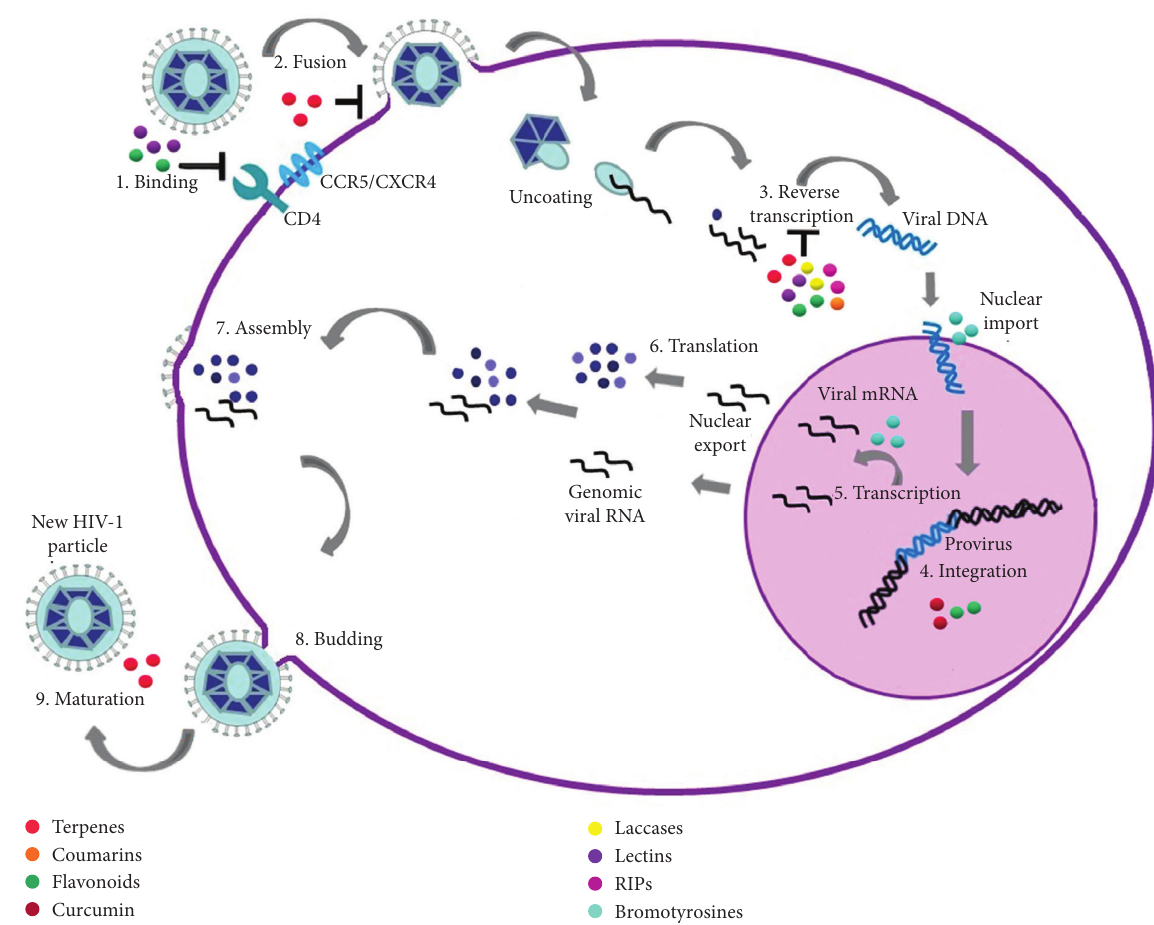
Figure 1: HIV-1 replication cycle exhibiting the sites of action of different natural products with anti-HIV-1 activity. Evidence suggests that flavonoids and lectins have an inhibitory effect on viral binding (1); terpenes inhibit virus fusion (2), whereas laccases, ribosome-inactivating proteins (RIPs), lectins, flavonoids, coumarins, and terpenes act on reverse transcriptase (3). Conversely, flavonoids and curcumin inhibit viral DNA integration (4), and bromotyrosines act on the transcription of the viral DNA (5). Finally, it has been reported that several terpenes act as inhibiting protease-mediated maturation of viral particles